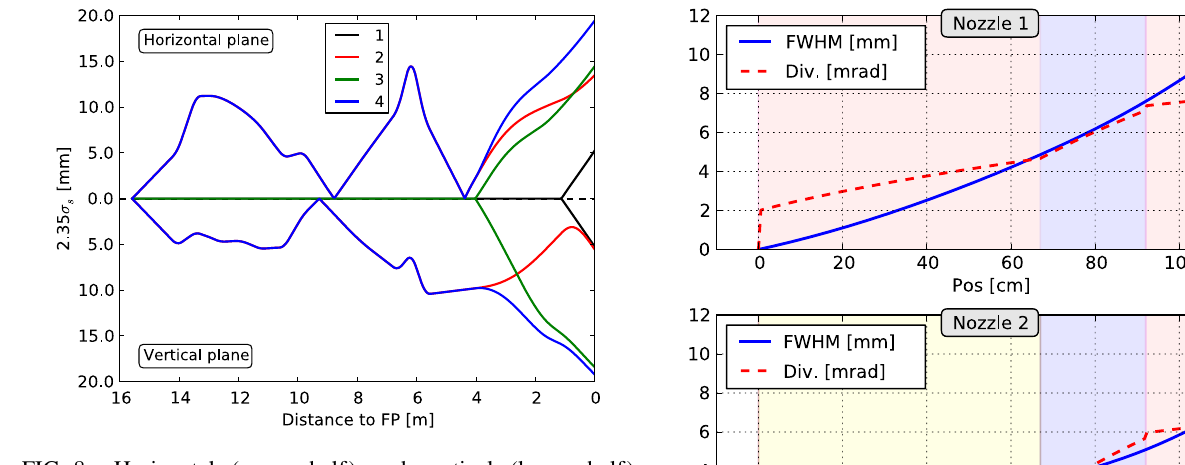
FIG. 8. Horizontal (upper half) and vertical (lower half) FWHM along gantry for geometries 1–4 (Fig. 6). The incoming beam is a 60 MeV proton point